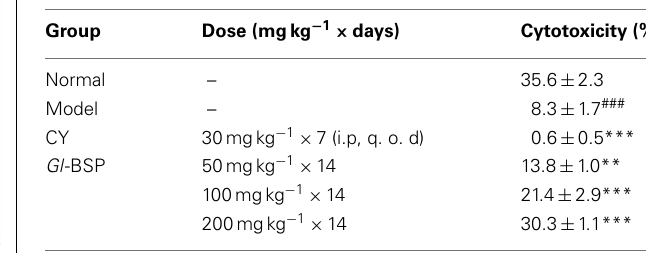
Table 4 | Effect of Gl -BSP on splenic NK cytotoxic activity in S180-bearing mice ( n = 5, ¯ x ± s).